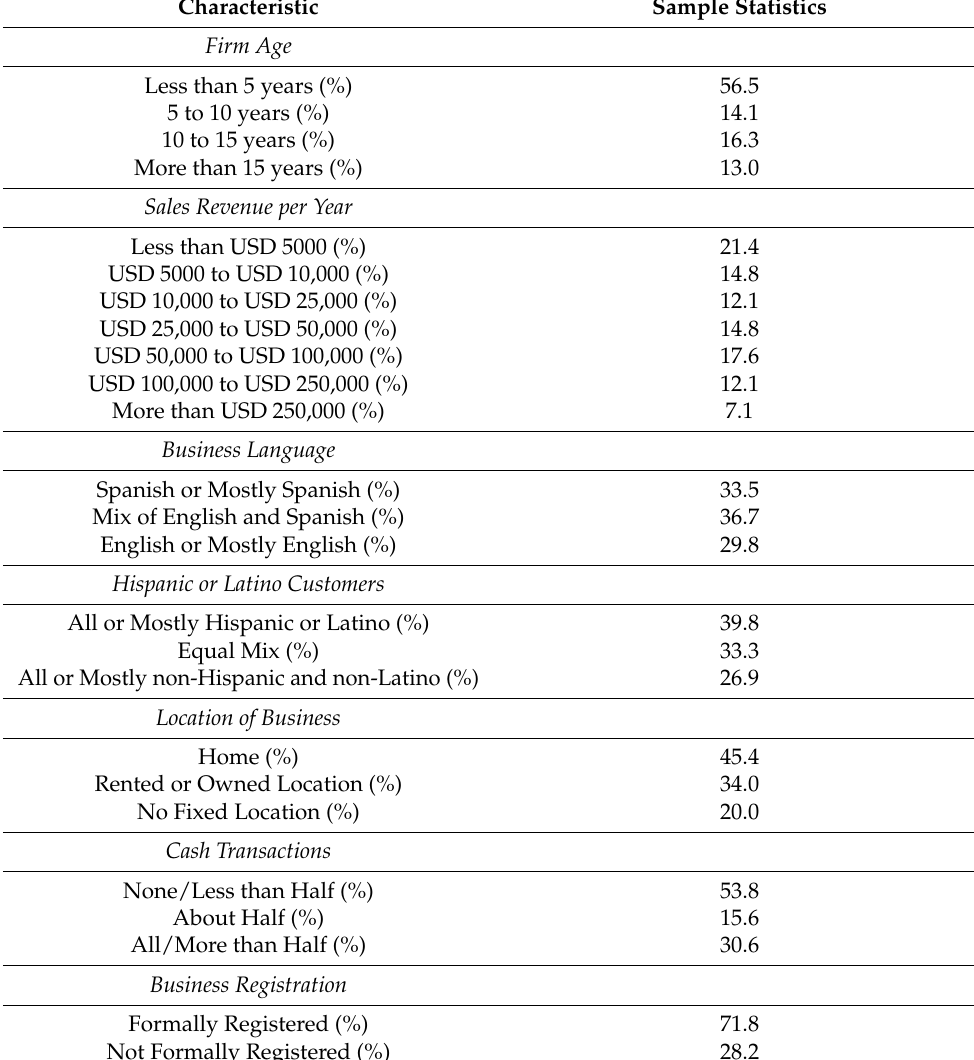
Table 2. Descriptive Statistics for the Businesses in the